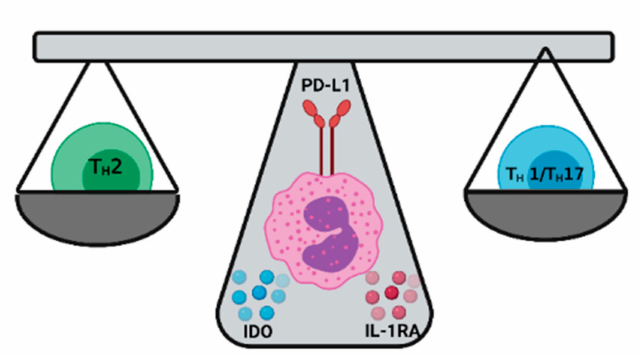
Figure 3. Eosinophilic maintenance of T H 1/T H 2 balance. Eosinophilic expression of IDO, PD-L1, and IL-1RA maintains the homeostasis between type I and type II immune responses. Generally, the secretion of these molecules is to control over-reactive pro-inflammatory